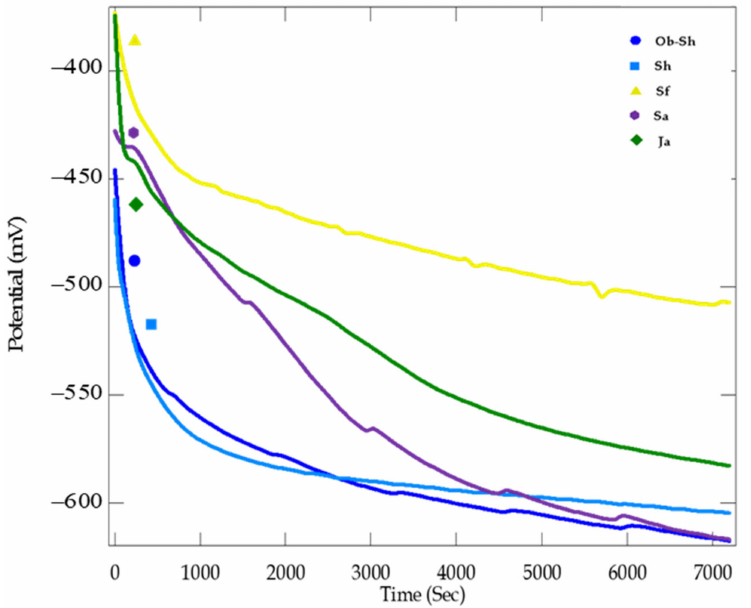
Figure 8. OCP curves for the corrosion of CSX36 specimen in the studied Jeddah soil solutions at 30 ± 1 ◦